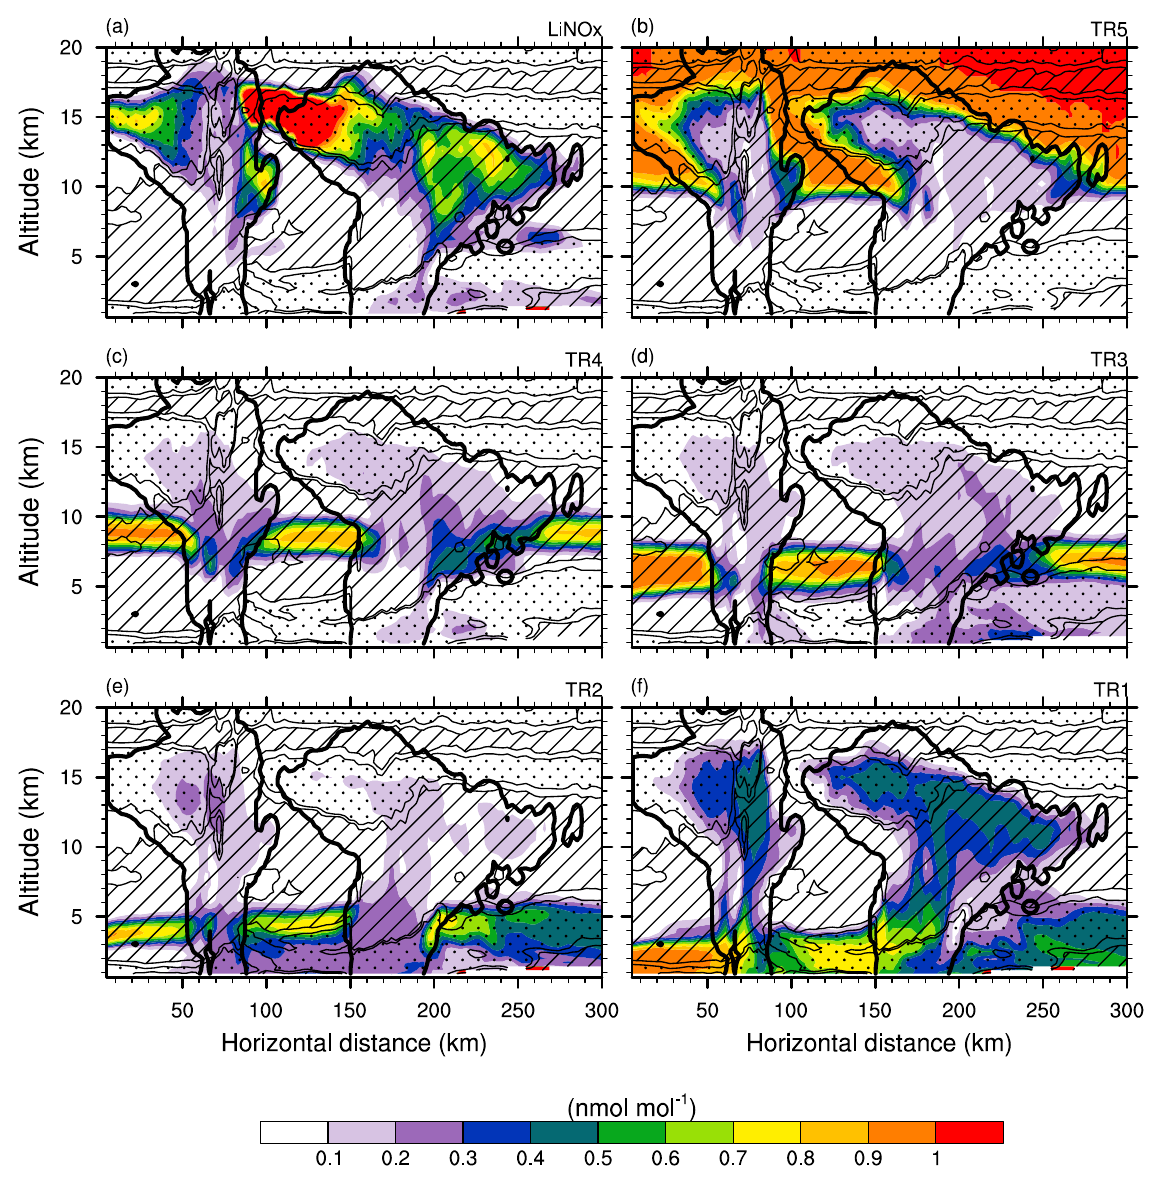
Fig. 10. Vertical cross section along the propagation axis (segment [A1 A2] in Fig. 6) of the tracers concentration (nmolmol − 1 ) and of the perturbation of the horizontal component of the wind velocity from the initial wind field (dashed and dotted patterns are for the positive and negative values, respectively) on 15 August 2004 at 19:00UTC. The contours for the horizontal wind perturbation are plotted at ± 1.5ms − 1 . The black solid line shows the cloud